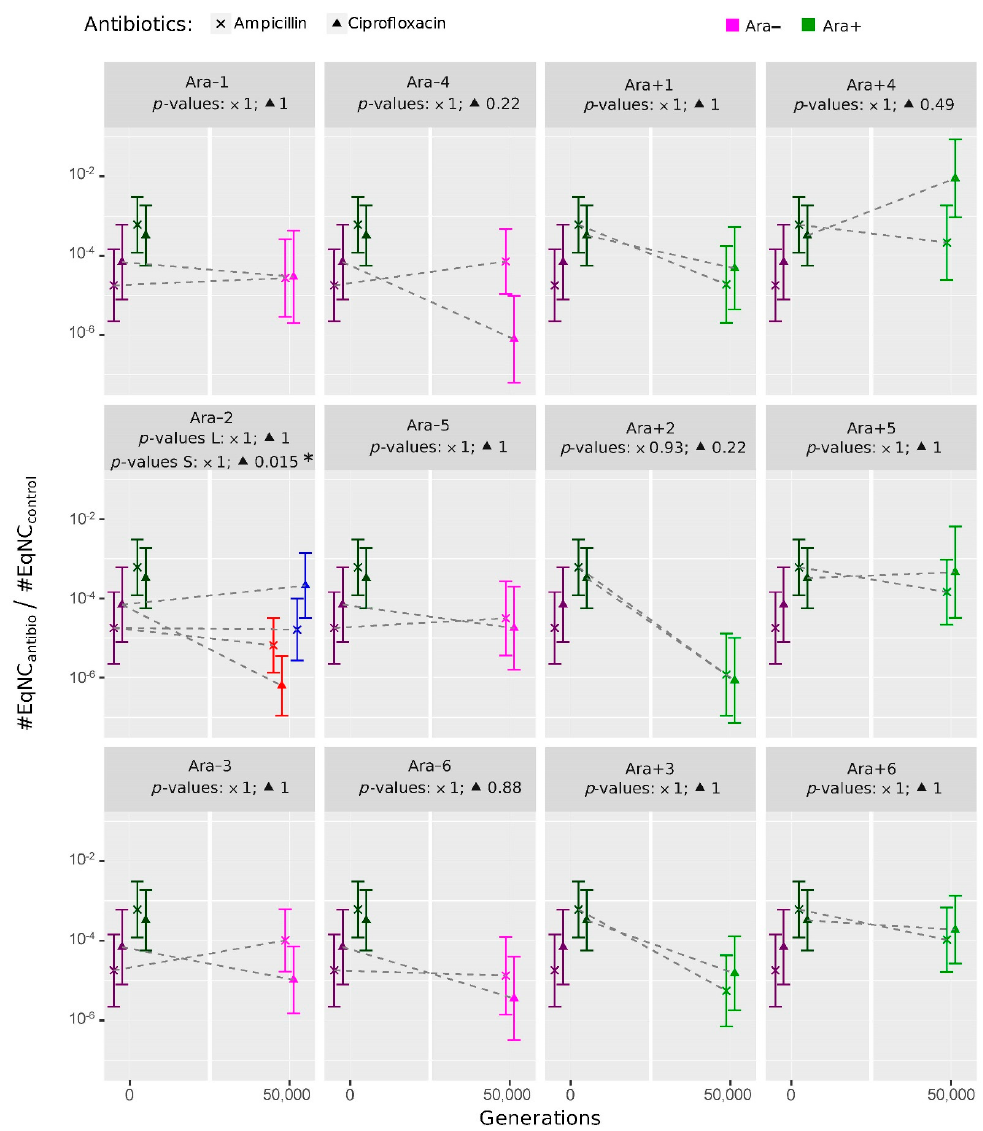
Figure 2. Evolution of persistence to ampicillin (×) and ciprofloxacin ( ▲ ) in evolved clones sampled from the 12 LTEE populations. For each antibiotic, we compared the level of persistence of each evolved clone sampled at generation 50,000 to the one in each of the two ancestors, REL606 and REL607, and to be conservative, only the least significant of the two comparisons was kept for each evolved clone. The p -values for each antibiotic are shown below the name of the population (and for each of the S and L ecotypes in population Ara − 2, in red and blue, respectively). These values were obtained from the coefficients of the models summarized in Table 2. The 95% confidence intervals are shown. Dark symbols represent the ancestor strains, pink represent the clones from the Ara − 1 to Ara − 6 populations, and green represent the clones from the Ara+1 to Ara+6 populations.